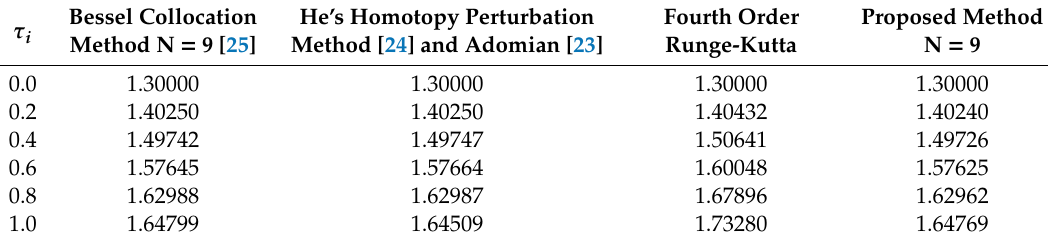
Table 9. Comparison between RC collocation method and other methods for u N ( τ ).